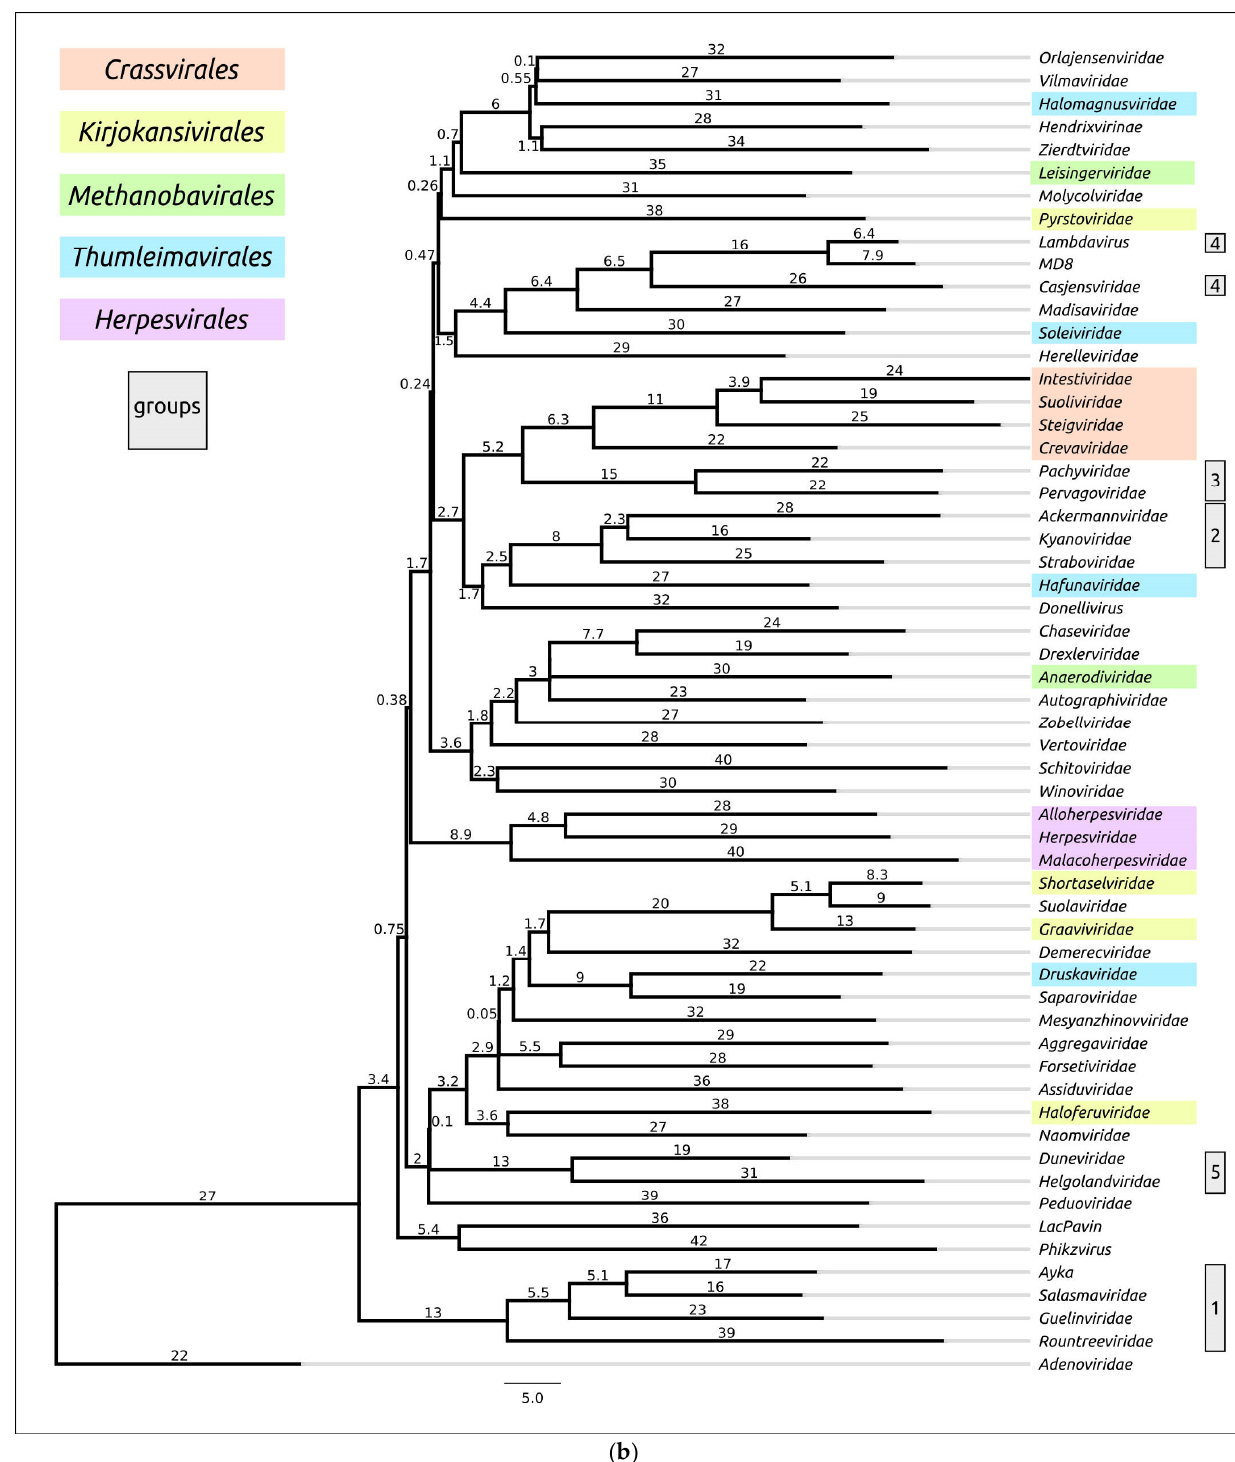
Figure 8. Matrix ( a ) and dendrogram ( b ) based on the pairwise Z-score comparisons of 58 AF models of ATPase subunit of terminase including an Adenoviridae terminase, using DALI. The branch lengths are measured using the DALI Z-score and the tree was rooted to Adenoviridae .